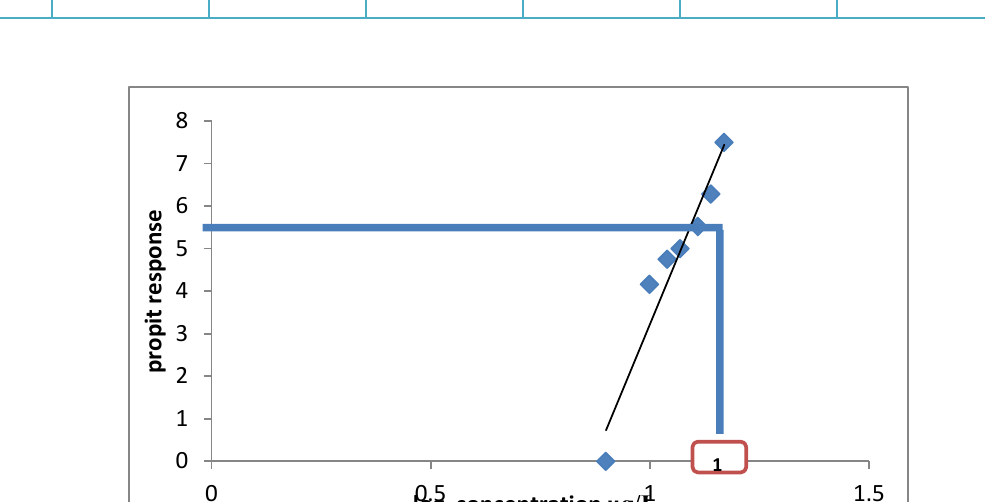
Fig. 1: Linear relationship between probit response and log concentration of median lethal concentration for endosulfan in